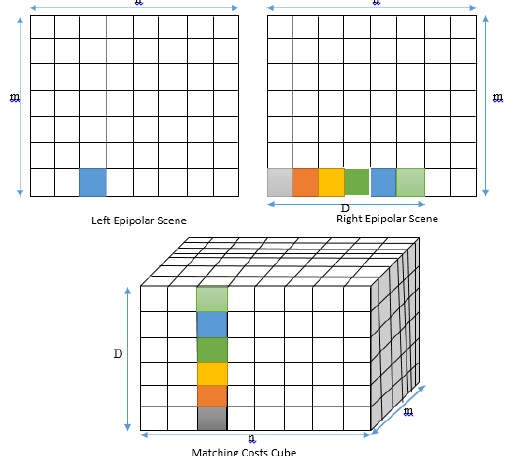
Figure 2. Matching cost computation and costs cube formation in SGM algorithm